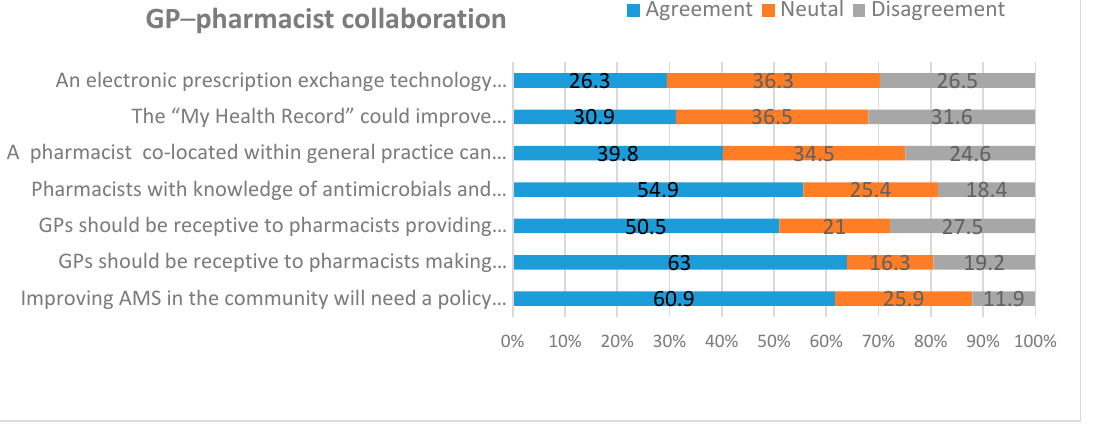
Figure 3. Proportion of GPs agreeing with GP–pharmacist collaborative approaches to improve AMS.